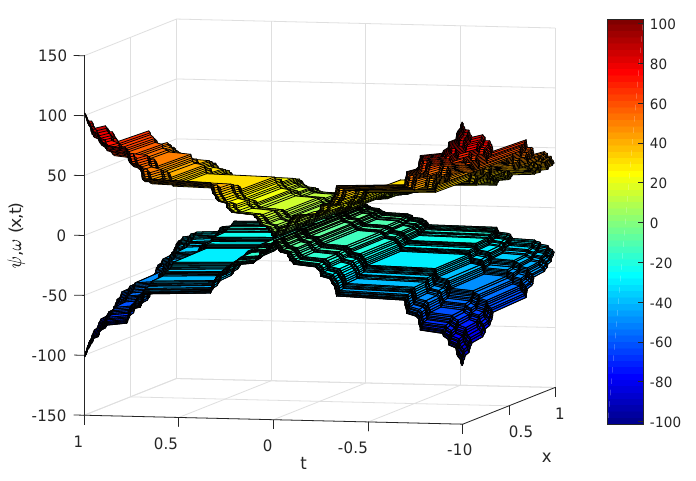
Figure 3. In the case of local fractional sine-Gordon equations, by choosing parameters A = 1, k = 1, c = 1, δ =